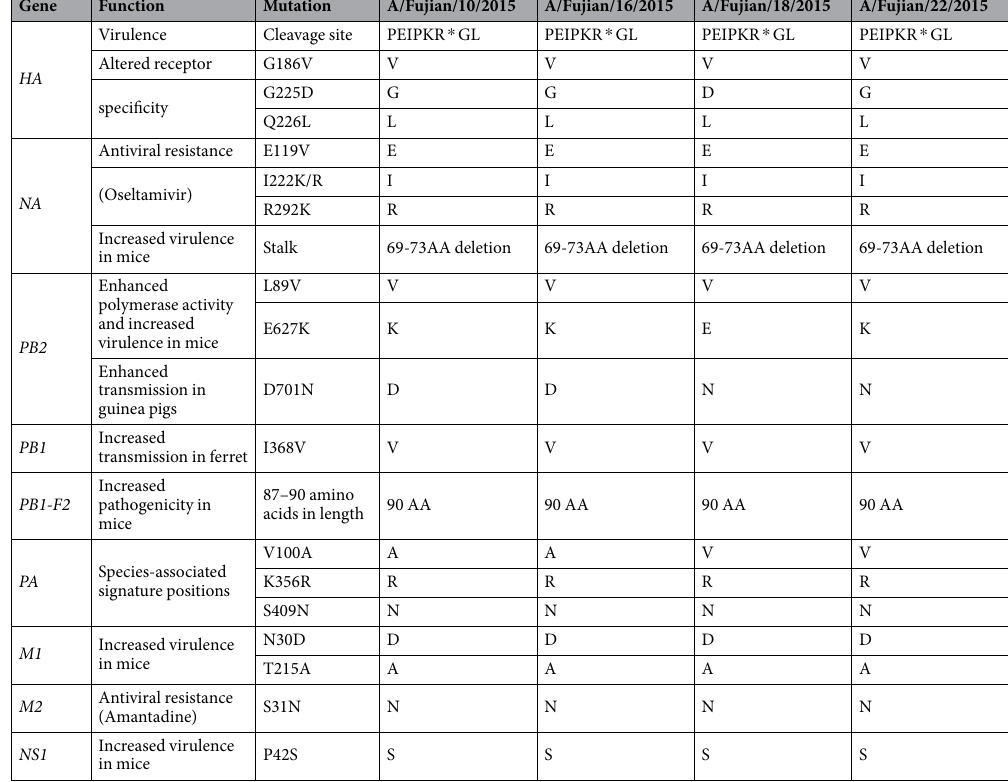
Table 4. Molecular analysis of H7N9 viruses from the family clusters. Note: The HA gene was under the H3 numbering system and the NA gene under the N2 numbering system. Other internal genes were numbered from the start codon